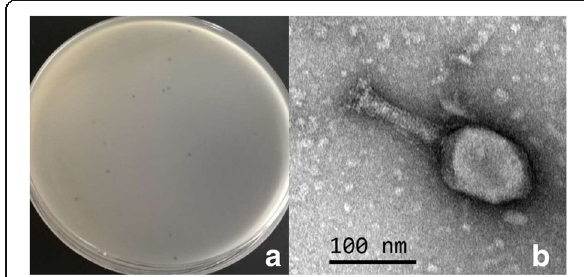
Fig. 1 Characterization of phage ST0 morphology. a The negative colony; b TEM image